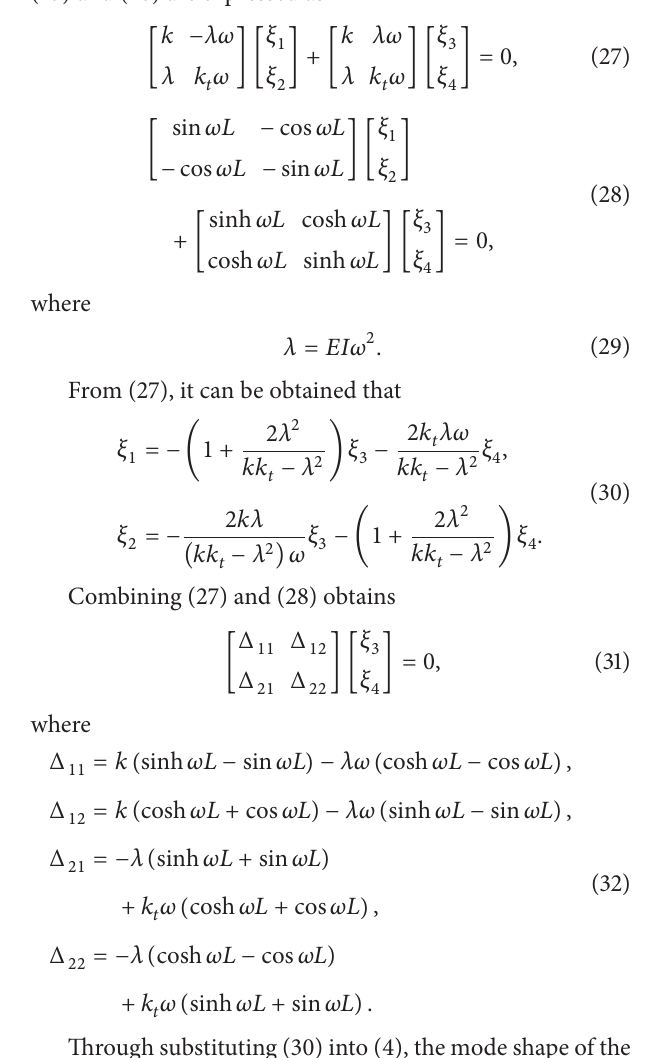
Figure 3: Elastic restraint model of the